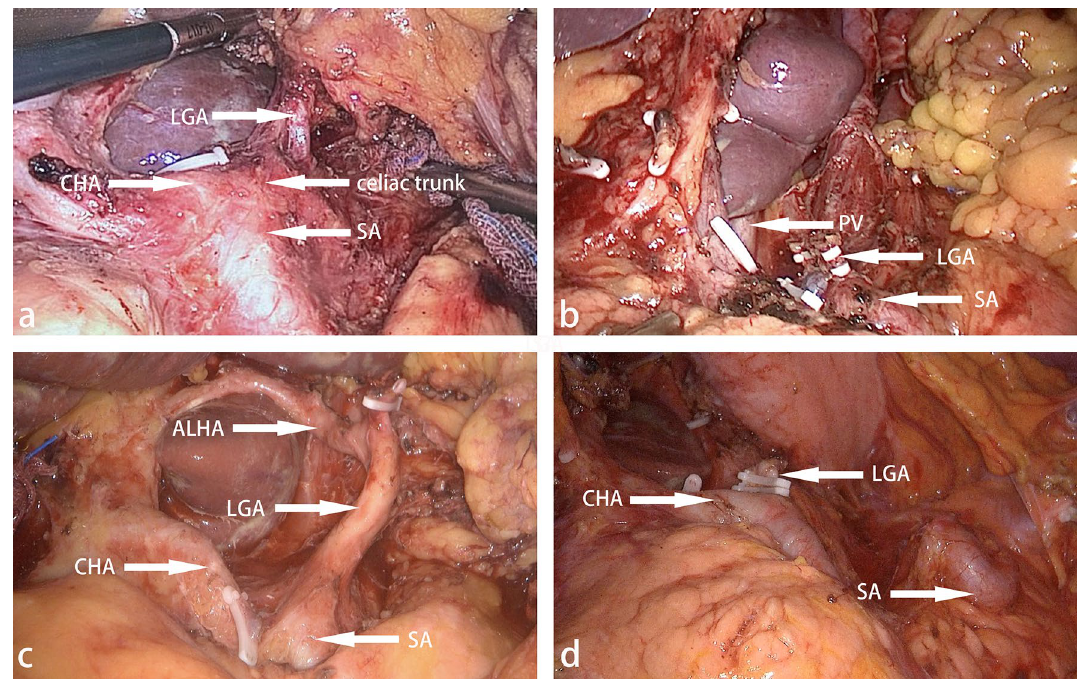
Figure 5. Several typical vascular variations during surgery. ( a ) LGA originated from AA, CHA and SA originated from the celiac trunk. ( b ) CHA originated from SMA. So we can’t find CHA in the suprapancreatic region, and the portal vein is directly exposed in the surgical field without occlusion of the CHA. ( c ) ALHA from LGA. ( d ) A spiral